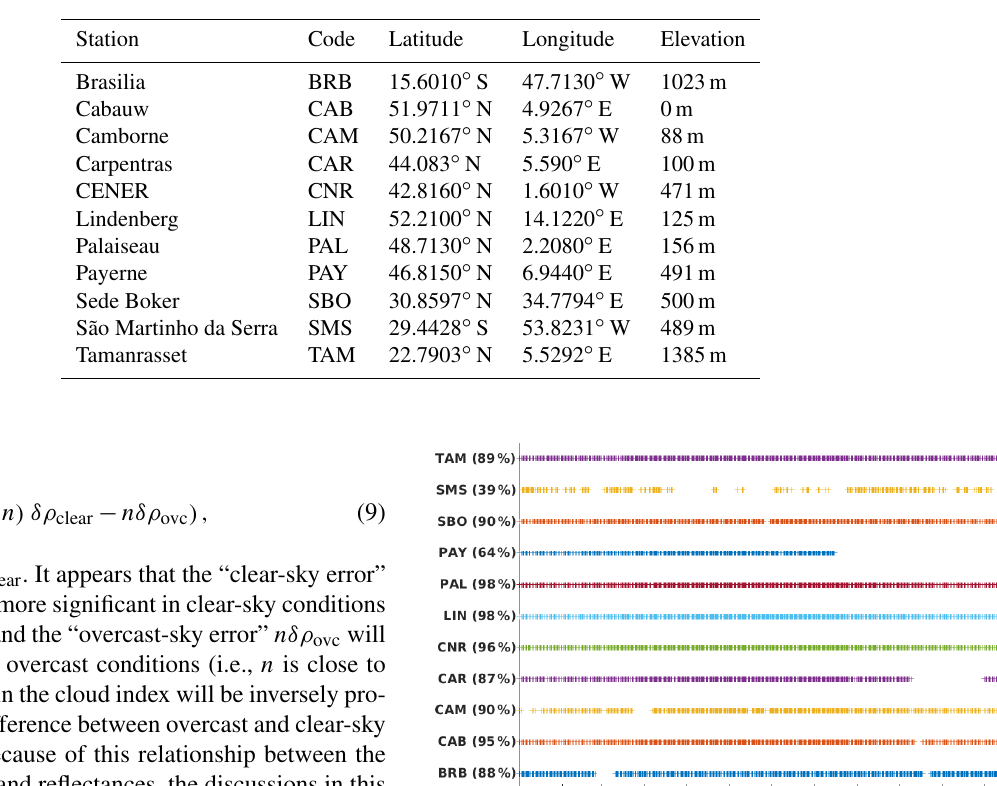
Table 3. List of BSRN stations used for validation.